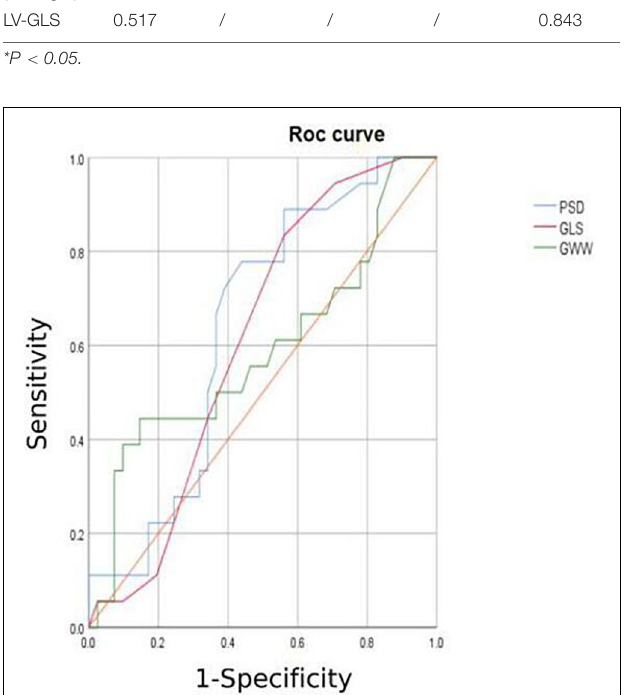
FIGURE 3 | ROC curve of GLS AND PSD.